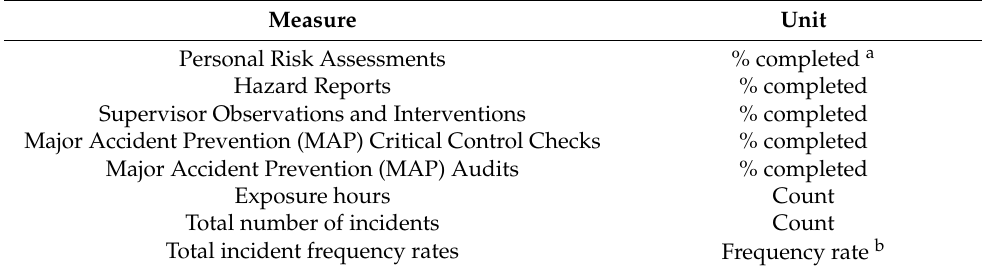
Table 3. Summary of Project Safety Performance Data-Risk Management Activities (Weekly). Measure Unit Personal Risk Assessments % completed a Hazard Reports Supervisor Observations and